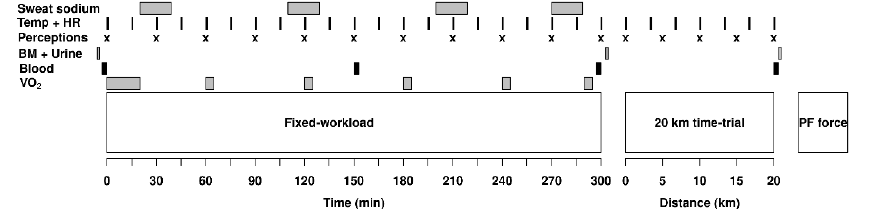
Figure 1. Timeline for the experimental procedures showing when the measurements of skin and rectal temperature (Temp), heart rate (HR), perceptions of thirst, effort, heat stress and abdominal discomfort (Perceptions), body mass (BM), urine specific gravity and osmolality (Urine), hematocrit, hemoglobin, sodium (Blood), sweat sodium concentration (Sweat sodium) and oxygen consumption (V ˙ O 2 ) were taken. The experiment was divided in three phases, a 5 h fixed-workload exercise period, a 20 km time-trial and a plantar flexors (PF) force measurement protocol.